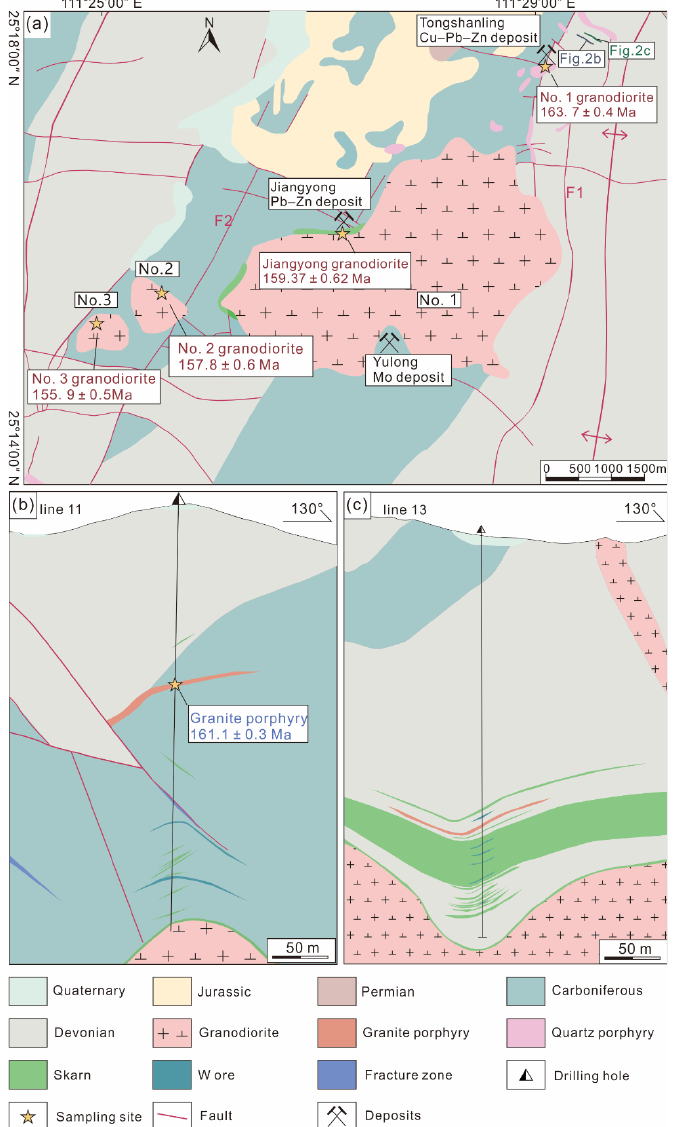
Figure 2. Geological map of ( a ) the Tongshanling area in southern Hunan Province (after [21]). Representative geological sampling location and cross – sections of ( b ) No. 11 exploration line and ( c ) No. 13 exploration line of the Tongshanling ore field.